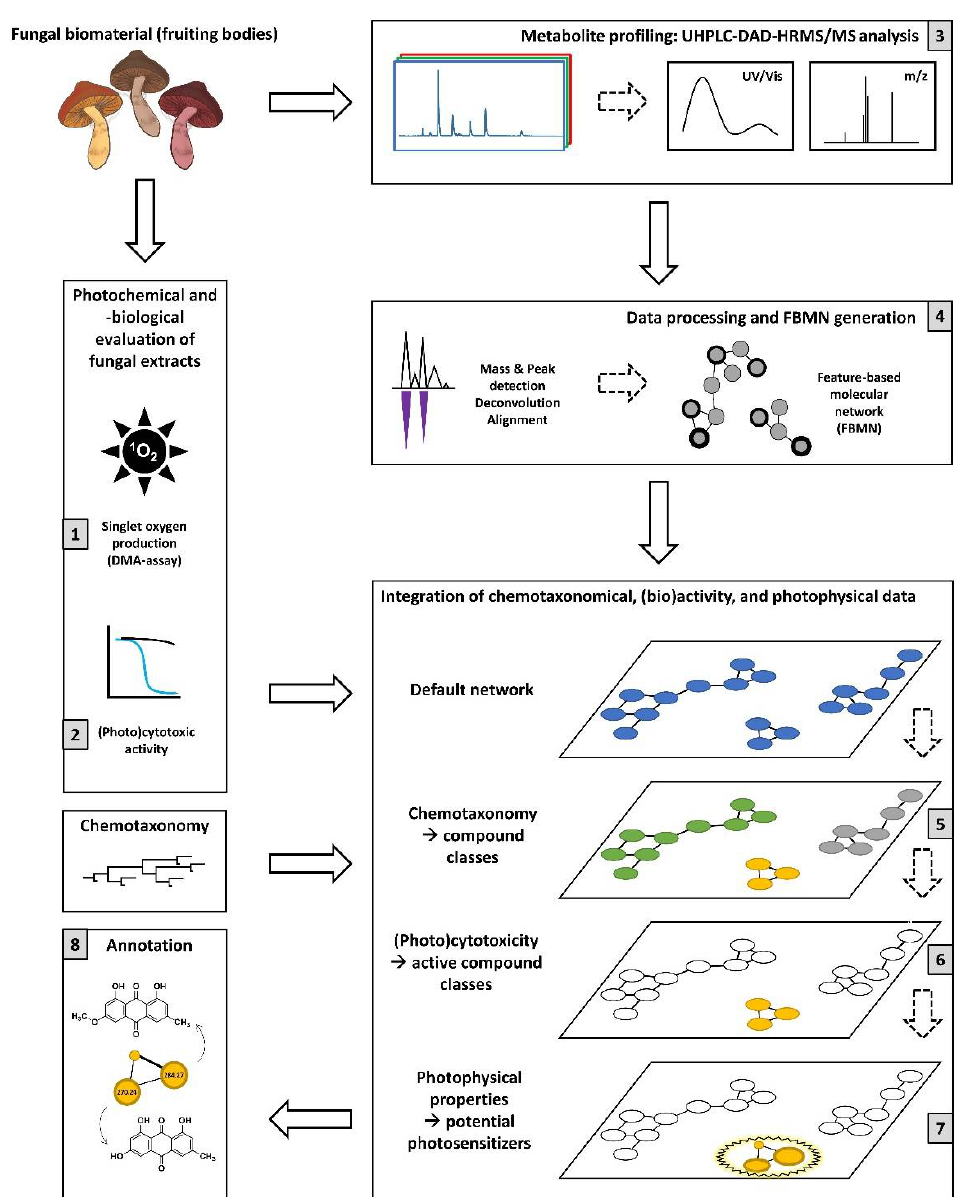
Figure 1. Graphical representation of the analytical strategy used in this study to explore the photochemical and biological properties of different Cortinarius species with feature-based molecular networking (FBMN).